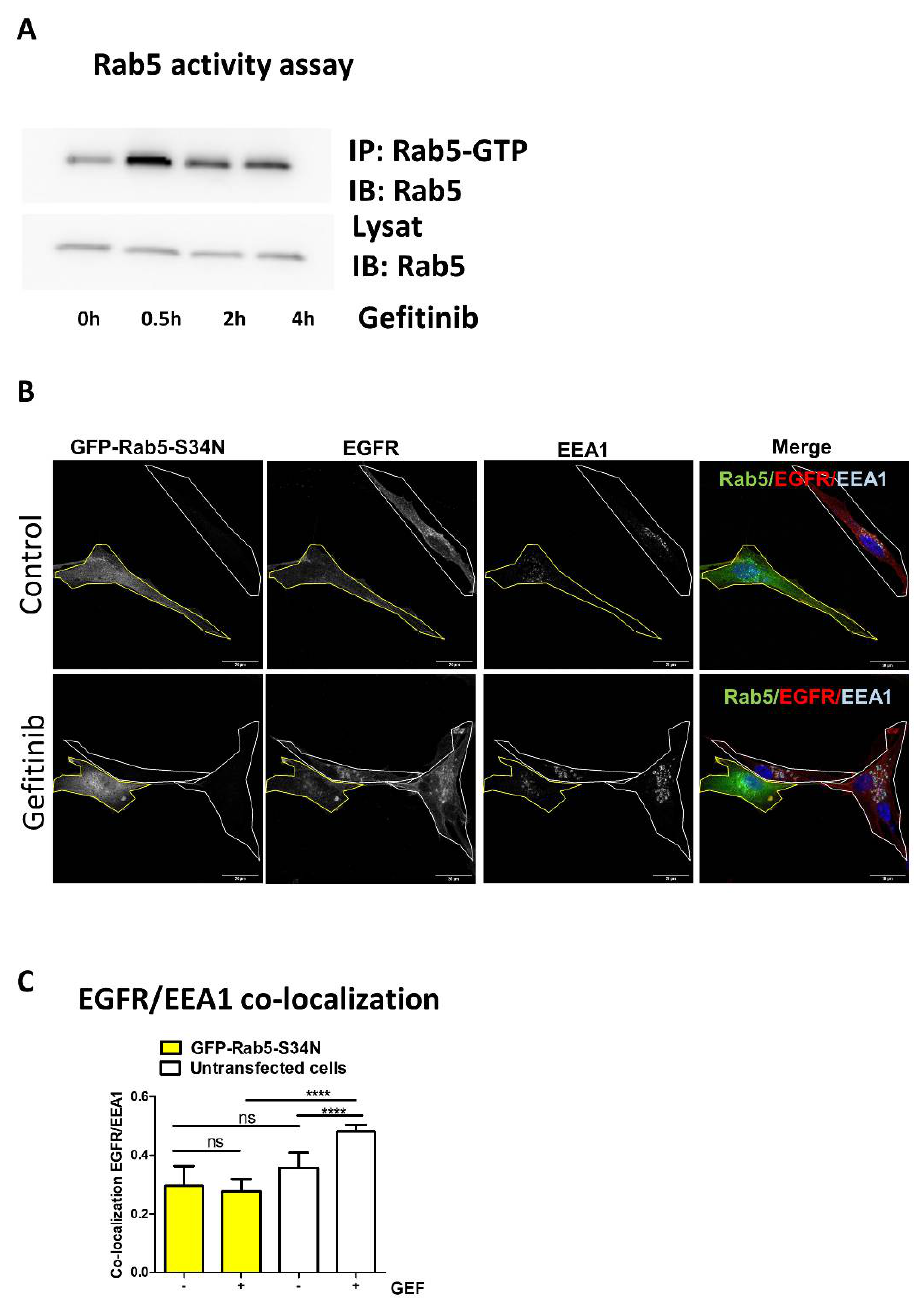
Figure 2. Gefitinib activates Rab5 to promote EGFR endocytosis. ( A ) Rab5 activity assay was per- formed in cell lysates upon gefitinib treatment. U87 cells were seeded the day before gefitinib treatment (20 µ M) for different periods of time. Cells were lysed and Rab5-GTP was immunoprecipi- tated. Rab5 was immunodetected in IP and control lysates. ( B ) U87 cells seeded on glass coverslips were transiently transfected with a dominant negative Rab5 mutant (GFP-Rab5-S34N). After treat- ment with gefitinib (4 h, 20 µ M), cells were fixed, then EGFR and EEA1 were immunodetected and analysed by confocal imaging. Single or merged channel images are represented. Transfected cells are delimited in yellow in all images. Scale bar = 20 µ m. ( C ) EGFR/EEA1 co-localisation upon gefitinib treatment in each untransfected cell (white bars) and GFP-Rab5-S34N expressing cell (yellow bars) was evaluated using Pearson’s correlation coefficient from 8 images (2–4 cells per images) in 3 independent experiments. Data reported as column histograms are the mean with 95% CI. **** p < 0.0001; ns: not